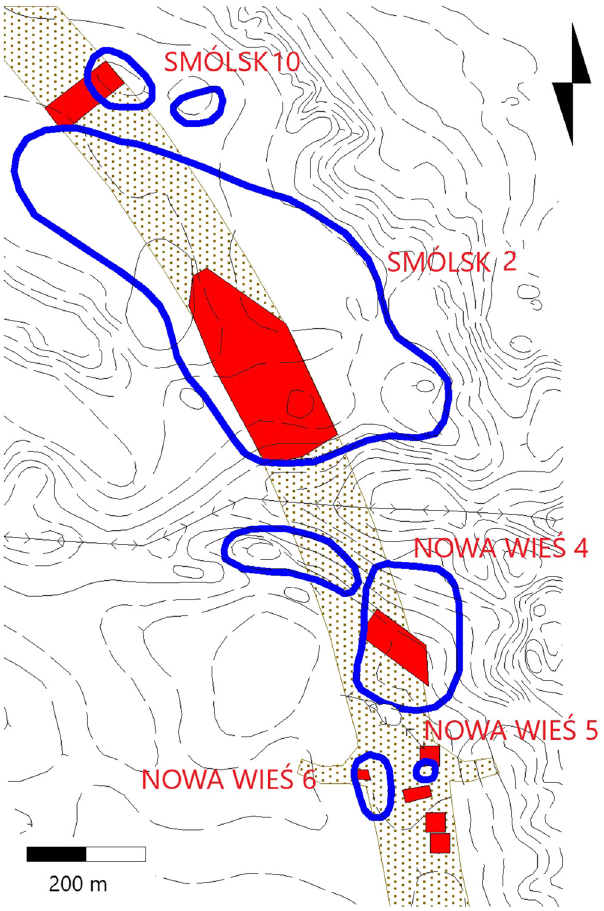
Figure 2: LBK settlement in the Smólsk microregion. Red area – LBK occupation, blue lines – boundaries of sites according to survey, dotted area – motorway